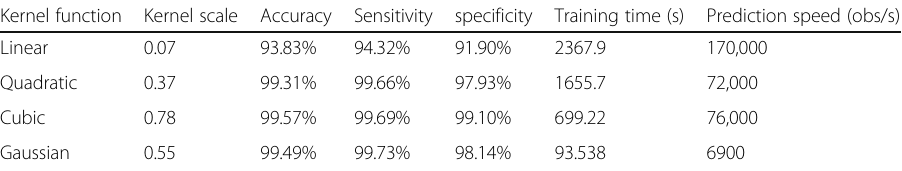
Table 3 Performances of SVM